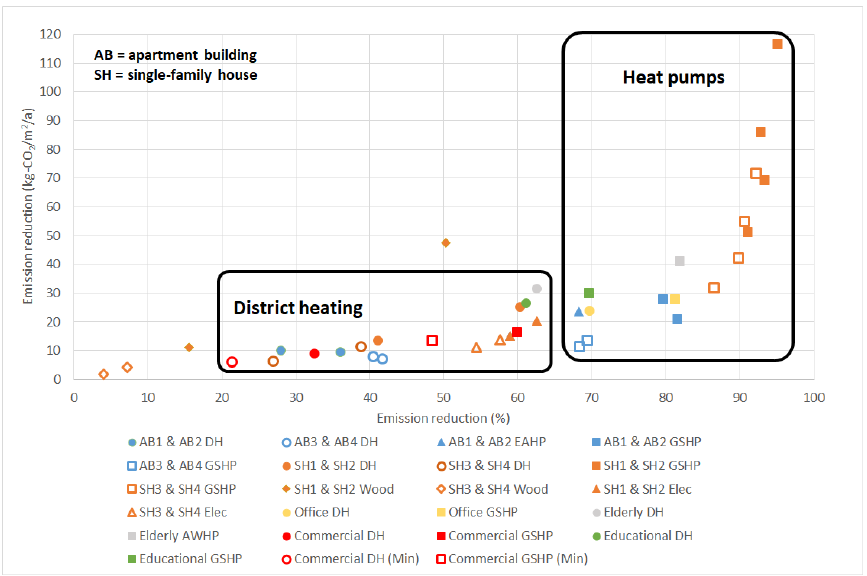
Figure 7. Absolute versus relative emission reduction in all building types.